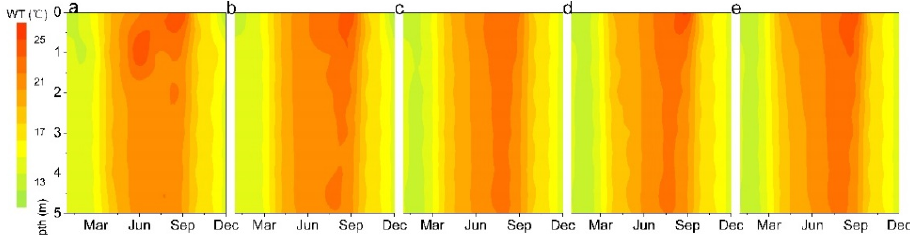
Figure 3. Spatiotemporal variation in temperature in Lake Xingyun, measured during 2017. ( a ) XYH-1. ( b ) XYH-2. ( c ) XYH-3. ( d ) XYH-4. ( e ) XYH-5.